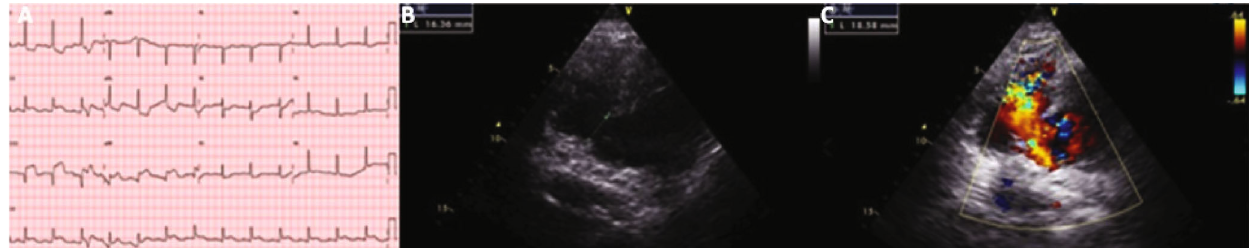
Figure 1: (a) ECG showing ST-segment elevation in the inferior leads with Q waves. (b) and (c) TTE showing a 18 mm VSR with left-to- right shunting by color-Doppler.